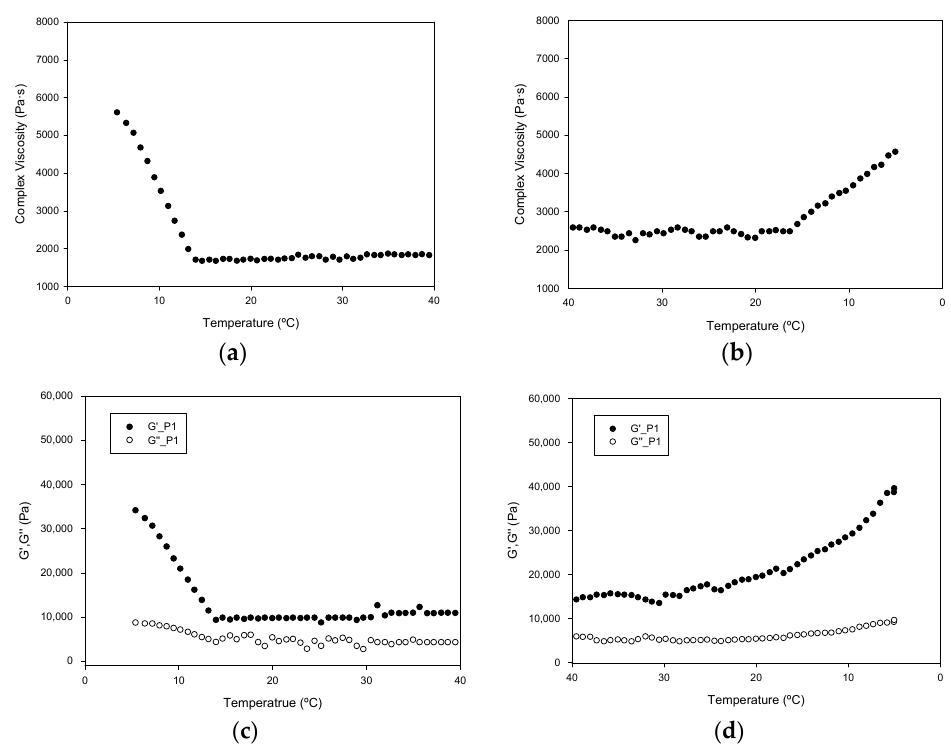
Figure 5. Variation with temperature of complex viscosity ( a, b ); and storage modulus (G ′ , filled circle) and loss modulus (G ′′ , empty circle) ( c , d ) for a 30% solution ( w/v ) of salmon gelatin P1. Heating ramp (left column) from 5 to 40 °C, cooling ramp (right column) from 40 to 5 °C. The values of the storage modulus G (cid:48) were found higher than the loss modulus G